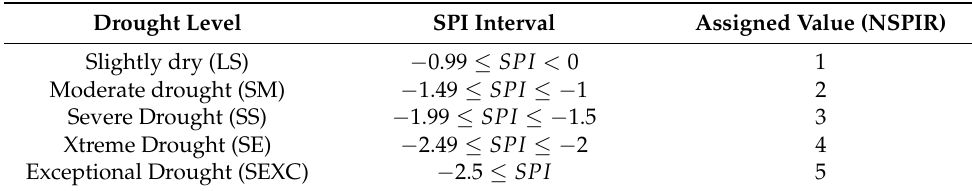
Table 2. Assigned values to the SPI levels according to the new